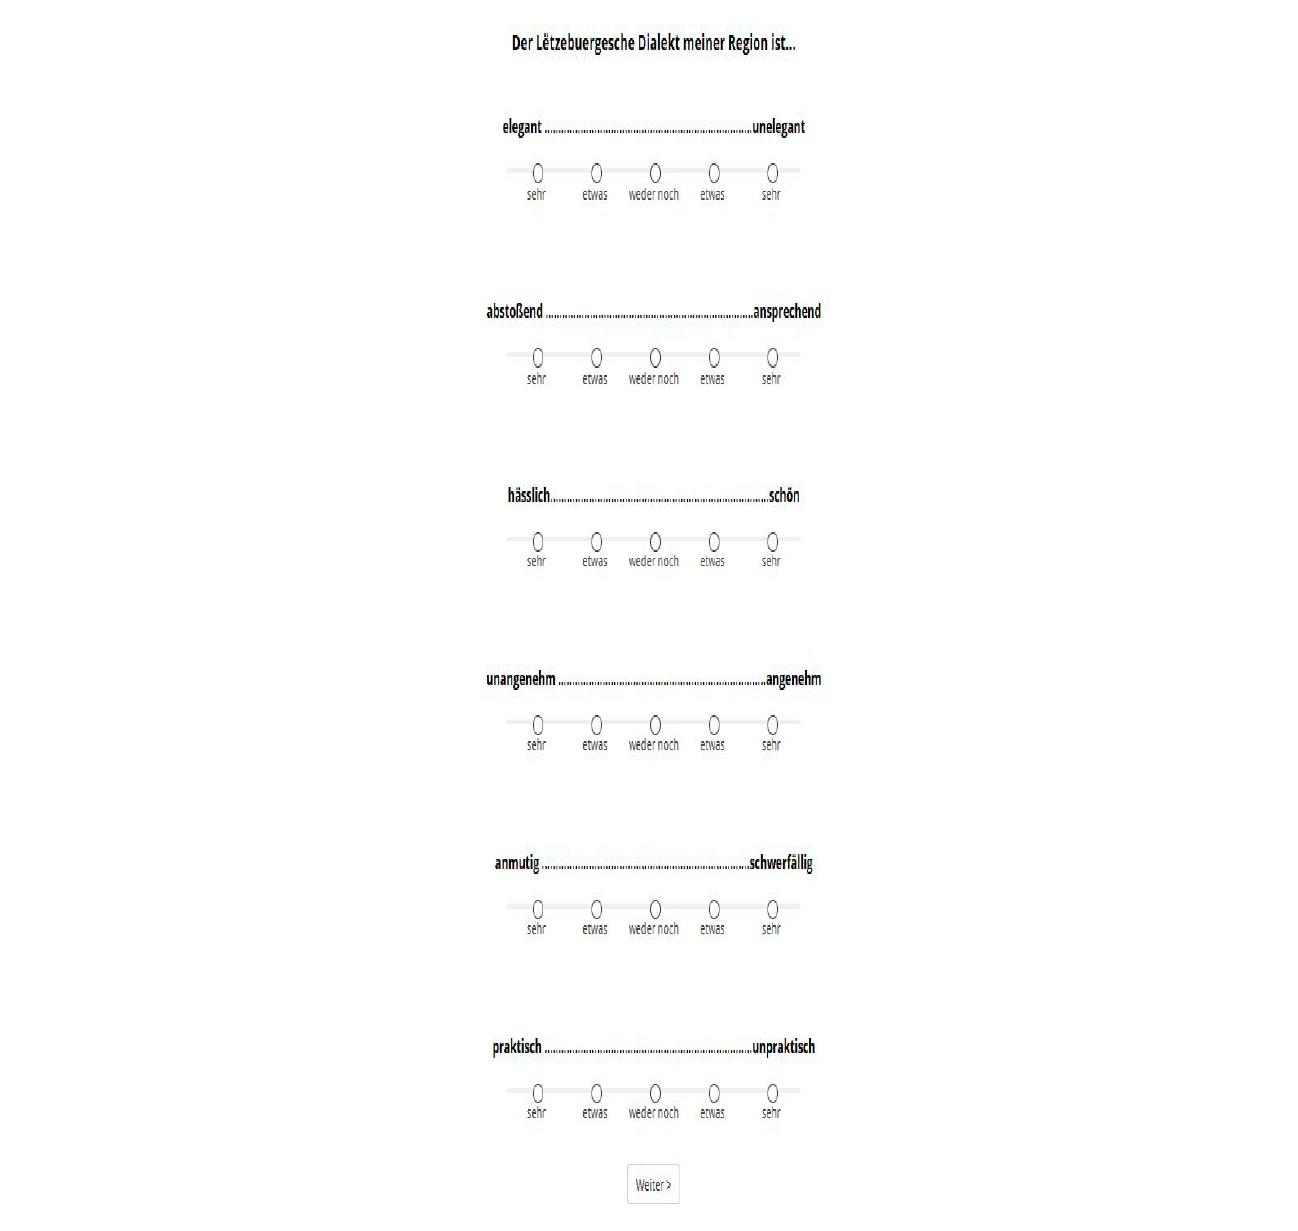
Figure A2. Semantic differential scales to measure attitudes towards the vernacular in Luxembourg.